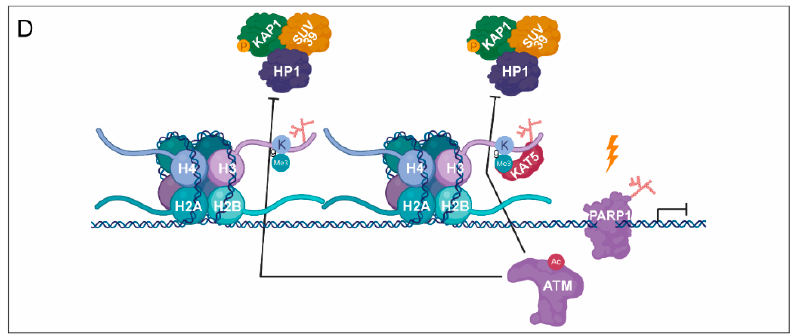
Figure 3. PARylation in transcription silencing during DNA damage. ( A ) As a response to DNA damage-induced transcription silencing, PARP1 facilitates the recruitment of SUV39H1, KAP1, and HP1. ( B ) Subsequent SUV39H1–HP1–KAP1 containing complexes are recruited, resulting in the spreading of H3K9me 3 signal. ( C ) KAT5 is activated, which acetylates ATM, being responsible for the phosphorylation of KAP-1. ( D ) Phosphorylation of KAP1 contributes to the dissociation of SUV39H1–HP1–KAP1 from the chromatin.